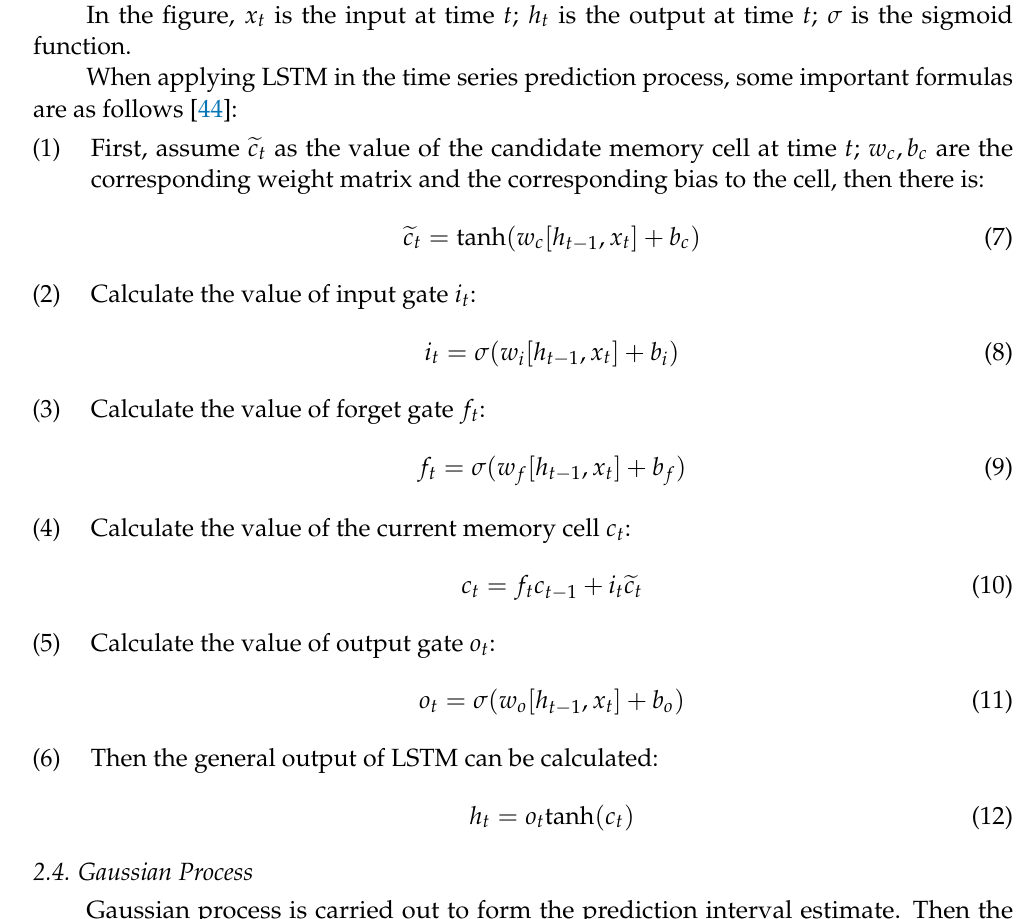
Figure 1. The general process of LSTM.